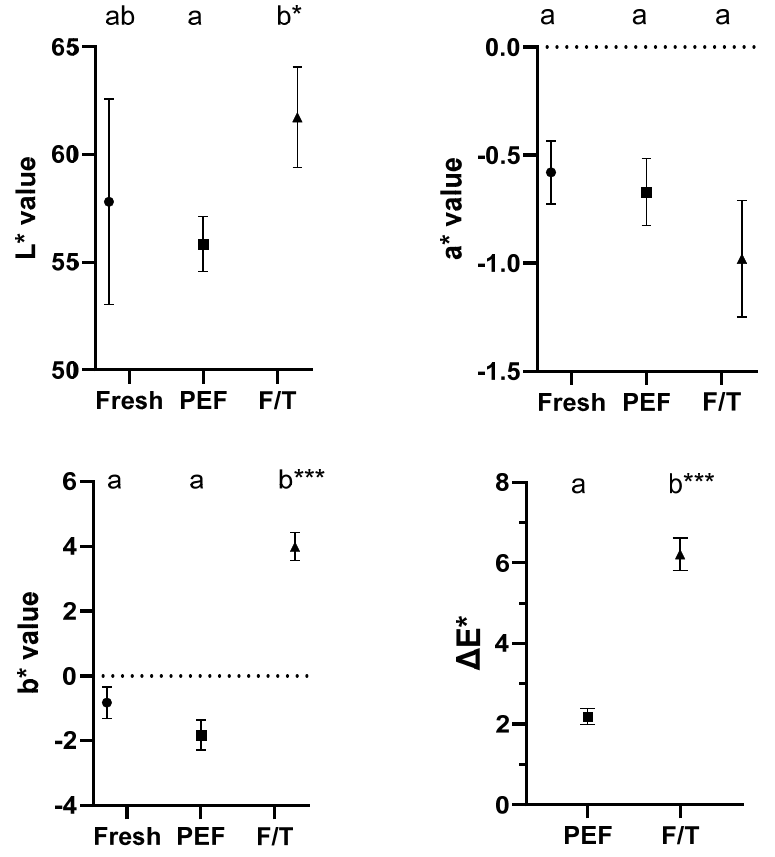
Figure 6. CIELAB parameters ( L* , a* , and b* ) and total color change ( ∆ E* ) for control ( • ), PEF-treated (3 kV/cm, 50 kJ/kg, and 30 µ s) ( (cid:4) ), and frozen/thawed (F/T) hake fillet samples ( (cid:78) ). Different letters indicate statistically significant differences among treatments ( p = 0.05). The * indicates the statistical significance of the differences: * ( p < 0.05); ** ( p < 0.01); *** ( p <